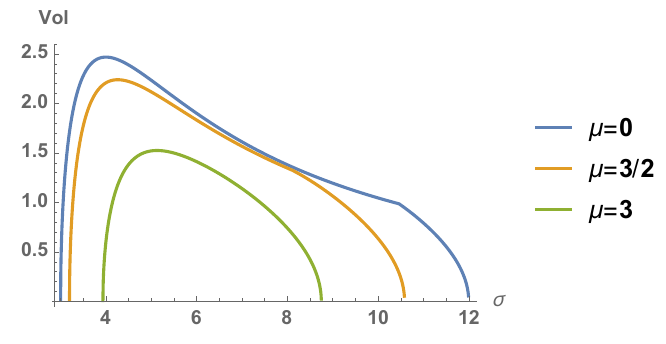
Figure 1 . The minimum size at the bounce as a function of (cid:27) for various values of the asymmetry parameter (cid:22) = 0 ; 3 = 2 ; 2. For the plot we have taken ‘ = 1 : In the time symmetric case ( (cid:22) = 0), the maximal value of (cid:25) 2 = 4 is reached for (cid:27) = 4 ; which is the de Sitter solution. Note that the corresponding curve contains a kink, which is due to the fact that there are two di(cid:11)erent times at which the universe bounces, see also the example in section 5 for illustration. Adding non-trivial q 1 ; 2 would lower all the curves in accordance with eq.